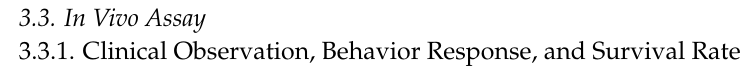
Table 3. Effect of exposure to 3 mg/L CWPNC on behavioral responses of O. niloticus infected with S. agalactiae for 7 days.